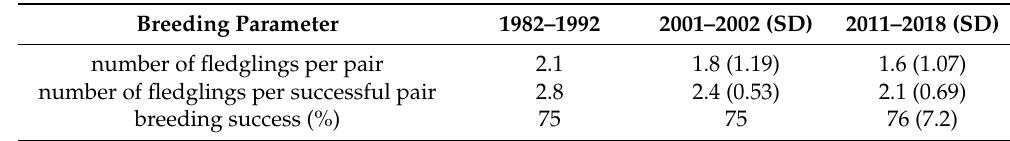
Table 3. The breeding parameters of the goshawk population in the area of study (central Poland, vicinity of Rog ó w village, Experimental Forest Station of Warsaw University of Life Sciences) in the three compared breeding periods: The data are for 1982–1992 [29], 2001–2003 [24], and 2011–2018, the current study. The SD values are given when data were available.